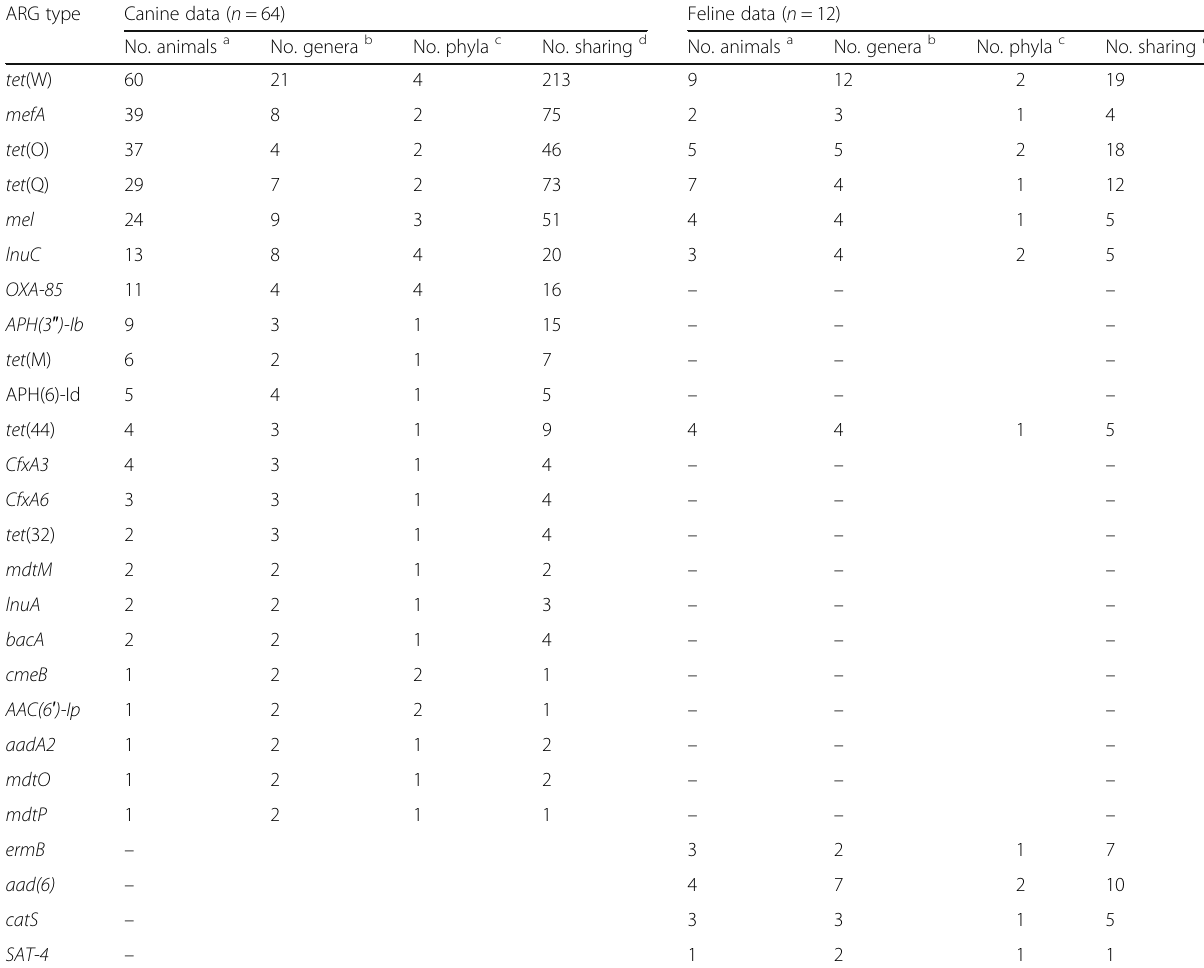
Table 2 The frequency of ARG sharing among contigs ARG